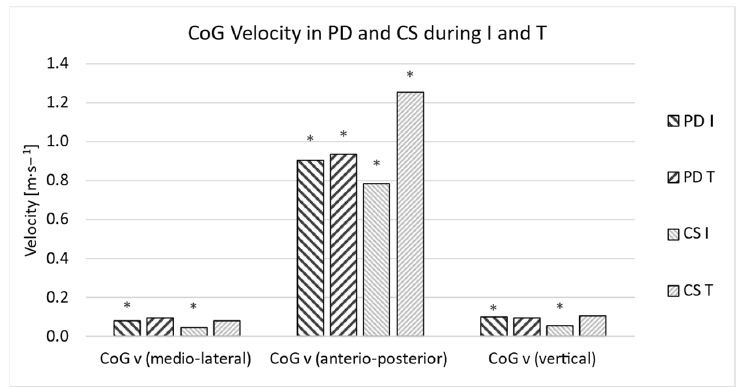
Figure 2. Centre of gravity (CoG) velocity development in PD and CS during step initiation (I) and termination (T). Parameters with a statistically significant difference between PD and CS are marked with an asterisk (*).